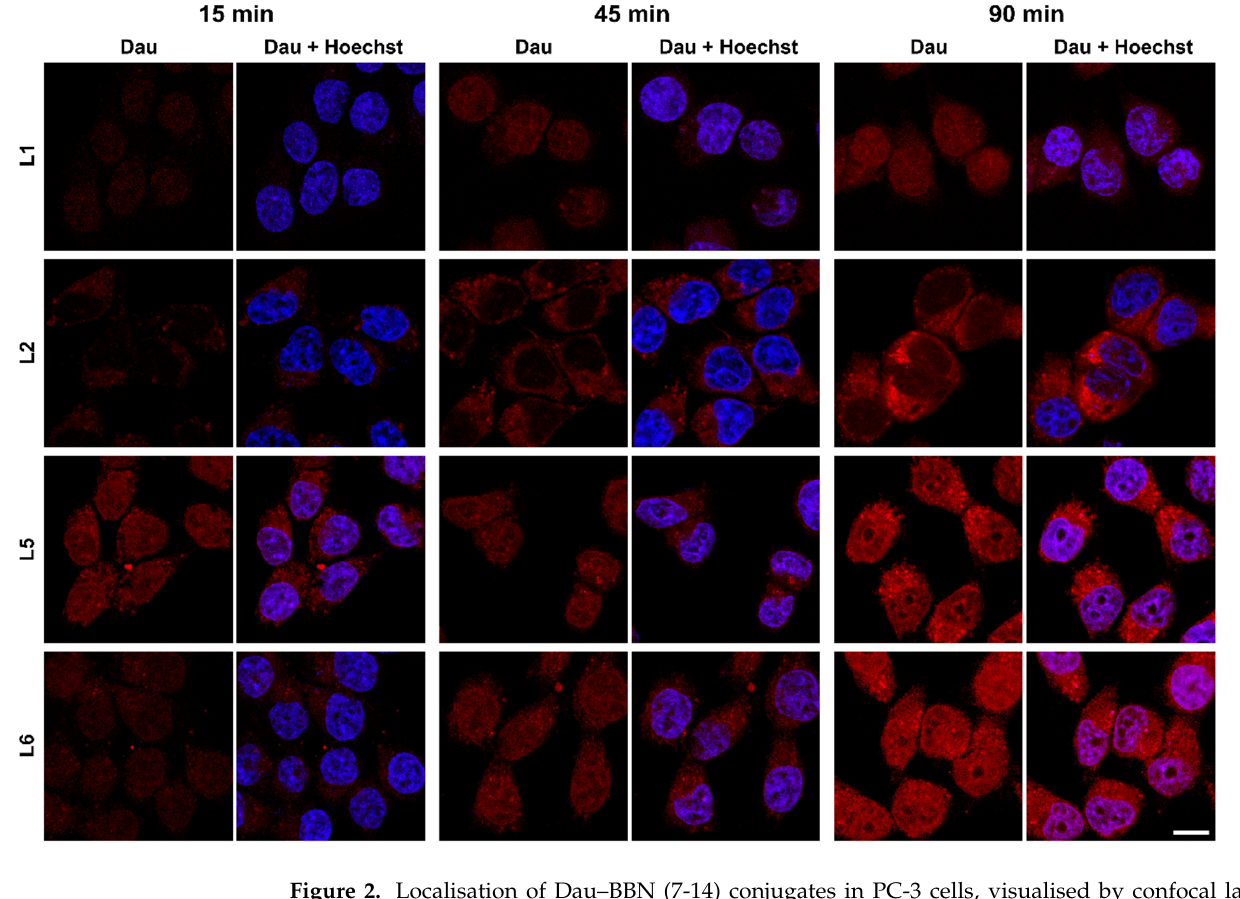
Figure 2. Localisation of Dau–BBN (7-14) conjugates in PC-3 cells, visualised by confocal laser scanning microscopy (CLSM). Conjugates were detected by the fluorescence of daunorubicin (red), nuclei were stained with Hoechst 33342 (blue). Scale bar: 10 µm.